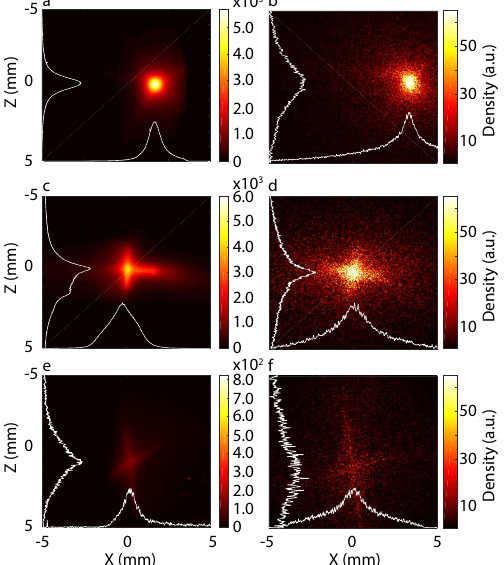
Figure 16. Transverse beam shape at the undulator entrance: measurements ( a , c , e ) and simulations ( b , d , f ). Simulations done with the high skew a 2 case (Table 2), (cid:101) z , i , (cid:101) x , i = 0.2 mm.mrad. = 2 mrad, σ (cid:48) = 4.7 mrad and the “Undulator entrance” optics. ( c , d ) With ( a , b ) With σ (cid:48) z , i x , i = 2 mrad, σ (cid:48) σ (cid:48) = 4.7 mrad and the “Undulator” optics. ( e , f ) With σ (cid:48) z , i x , i and the “Undulator exit” optics. Shot-to-shot pointing for ( a , c , e ): 0.85 ± 0.03 mrad, 0.13 ± 0.15 mrad, and 0.07 ± 0.02 mrad ( − 0.03 ± 0.05 mrad, − 0.03 ± 0.04 mrad, 0.18 ± 0.04 mrad) in the horizontal (vertical)